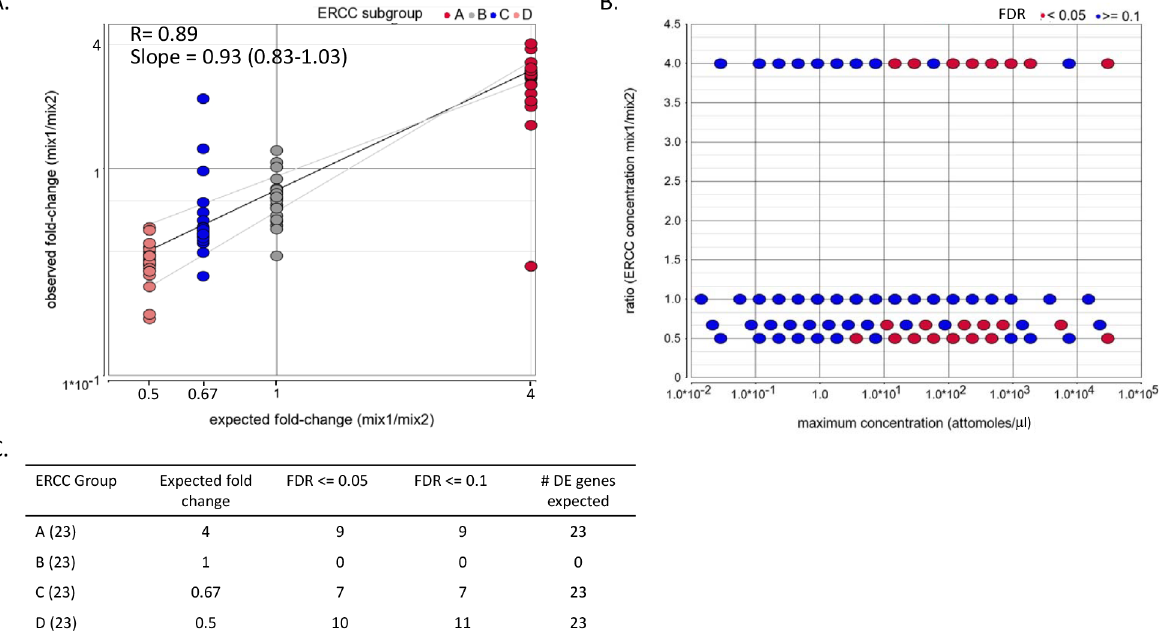
Fig 2. Analysis of ERCC spike-ins. Differential expression of ERCC spike-ins. (A) Scatter plot of DESeq2 normalized ratio between ERCC mix2 and ERCC mix 1 versus the expected ratio for day 0. Note the axes scale in the plot is logarithmic. The correlation coefficient and the slope were calculated on the log values. The gray lines represent 95% confidence interval of the slope. The slope confidence interval is indicated in brackets. (B) Scatter plot illustrating the relationship between the spike-in levels and differential expression detection capacities. The fold changes between the two ERCC mixes and the FDR were calculated using DESeq2. The maximum concentration (log 10 ) within the pairwise comparison is shown in the X- axis. (C) Number of significantly differentially expressed (DE) ERCC spikes.